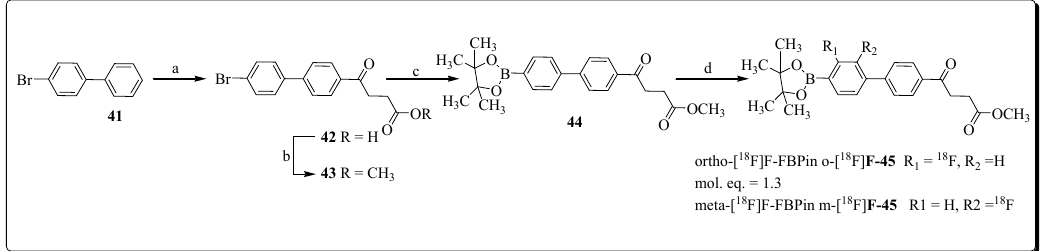
Figure 14. Preparation of boronofenbufen analogs O- and m-[ 18 F]- 45 . Reagents and condition (a) dihydrofuran-2,5-dione, AlCl 3 ; (b) CH 3 OH/H 2 SO 4 , 96% over two steps; (c) Bis (pinacolato)diboron, AcOK, Fe(C 5 H 4 )2(PPh 2 ) 2 PdCl 2 , DMF, 85%; (d) CH 3 COO[ 18 F]F/CF 3 COOH, 8%. Radioligand m -[ 18 F]FFBPin showed moderate COX-2 inhibition and selectivity (COX-2 IC 50 = 0.33 ± 0.24 µ M, COX-1 IC 50 = 0.91 ± 0.68 Mm) in a competitive binding assay. The assessment of radiotracer m -[ 18 F]FFBPin in a COX-2 overexpressing CCA tumor rat